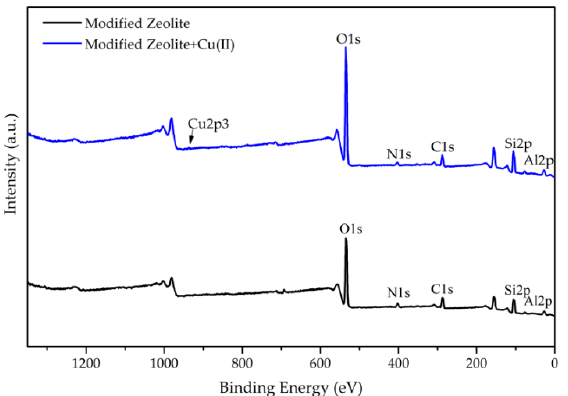
Figure 10. X-ray photoelectron spectroscopy (XPS) spectra of modified zeolite before and after the adsorption of Cu(II).